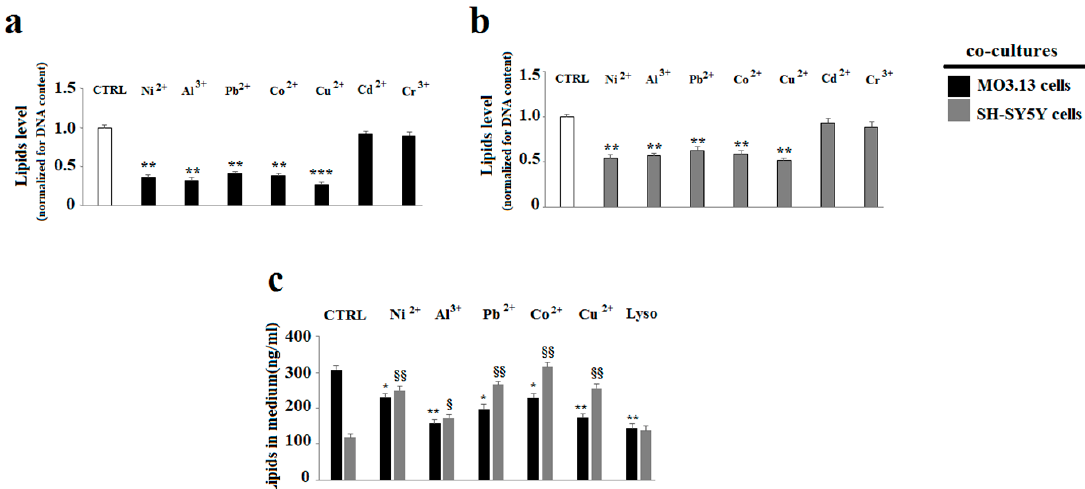
Figure 7. Lipid quantification through spectrometric analysis. Di ff erentiated human oligodendrocytes and human neurons (SH-SY5Y) were grown in co-culture and treated with heavy metals for 24 h. At the end of the treatment, the cells were incubated with Nile Red. Then, lipids were extracted through the Bligh & Dyer method. The lipid content relating to each sample was subjected to spectrometric reading. The values thus obtained were then normalised for the cellular DNA content. Panel ( a ) shows achieved results through the spectrometric analysis carried out on oligodendrocyte lipids. Panel ( b ) indicates the values obtained through spectrometric analysis carried out on neuron lipids. Panel ( c ) reports the achieved results through spectrometric analysis carried out on the lipids found in the media in contact with the two cell lines grown in co-culture. Lysolecithin 50 µ M per 24h was used as a positive control for demyelination. Values of three independent experiments are expressed as mean ± standard deviation (sd). * denotes p < 0.05 vs. control; ** denotes p < 0.01 vs. control; *** denotes p < 0.001 vs. control. § denotes p < 0.05 vs. control (grey bars); §§ denotes p < 0.01 vs. control (grey bars). Analysis of Variance (ANOVA) followed by the Tukey-Kramer comparisons test.